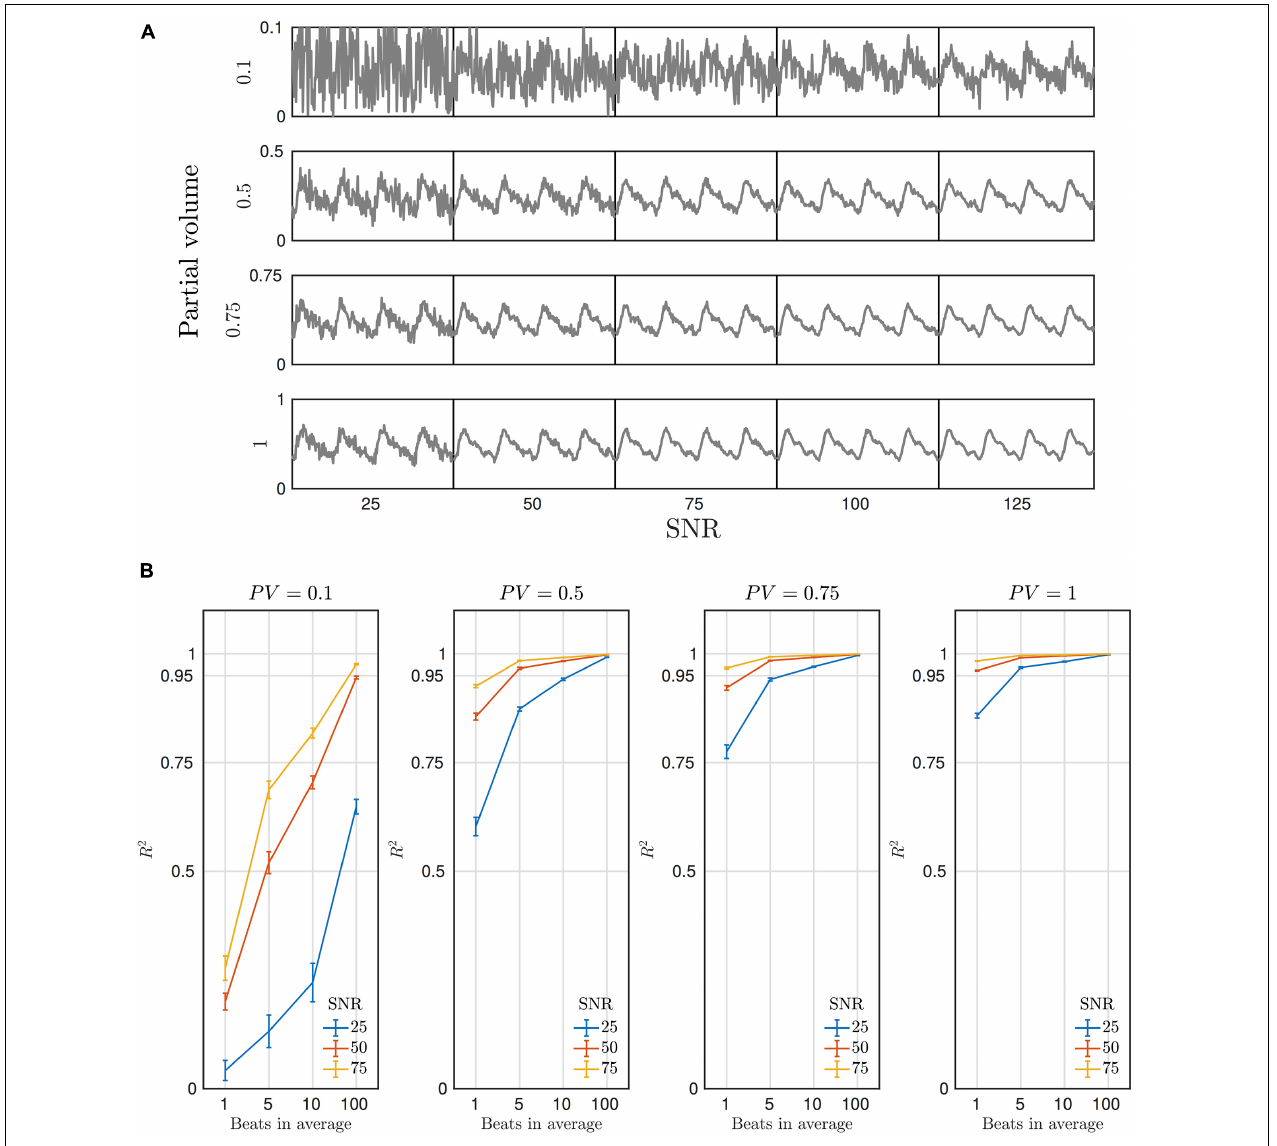
FIGURE 4 | (A) Simulated DIMAC signal over four beats. Each panel represents a different partial volume (row) and SNR condition (column). Note the different Y-axis scale for each partial volume. Thus, for a given SNR, increased partial volume of arterial blood increases signal magnitude and yields a stronger pulsatile signal. (B) Each panel shows the amount of variance explained in the true CBFV waveform by the simulated DIMAC signal as a function of number of beats included in the average. Naturally, as the number of beats included in the average increases more noise is averaged out, and thus the R2 increases. However, this also shows that when both partial volume and SNR are sufficiently high, individual beats can be resolved with high fidelity (i.e., a high R2 with respect to the true CBFV